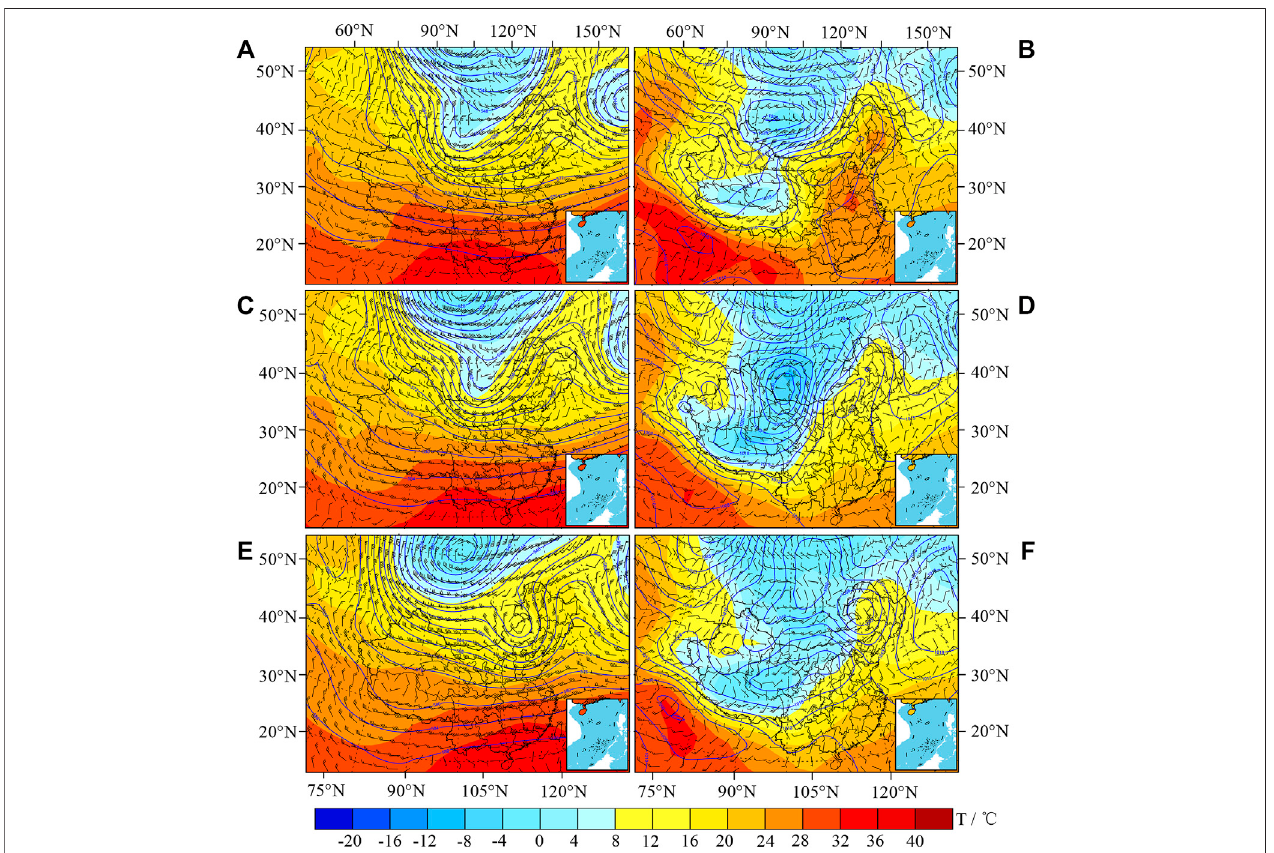
FIGURE7| Synopticsituationduringtheduststorm: (A) 500 hPaat08:00on11May; (B) surfaceat08:00on11May; (C) 500 hPaat20:00on11May; (D) surface at 20:00 on 11 May; (E) 500 hPa at 20:00 on 12 May; and (F) surface at 20:00 on 12 May.